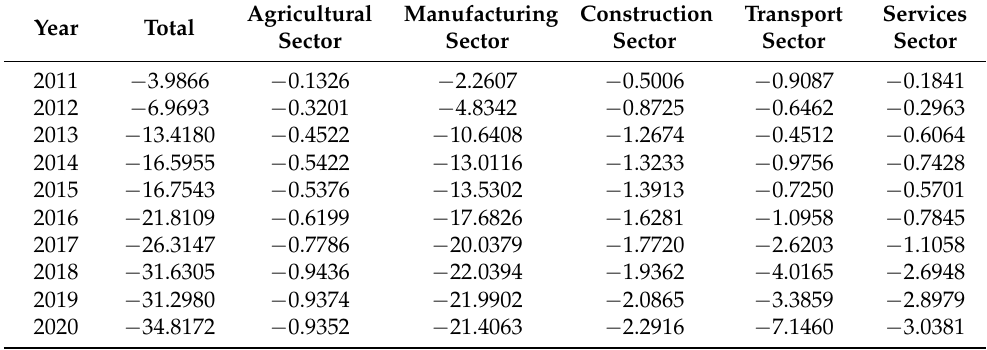
Table 3. Cumulative contribution of energy intensity impacts of different sectors on carbon emissions. Year Total